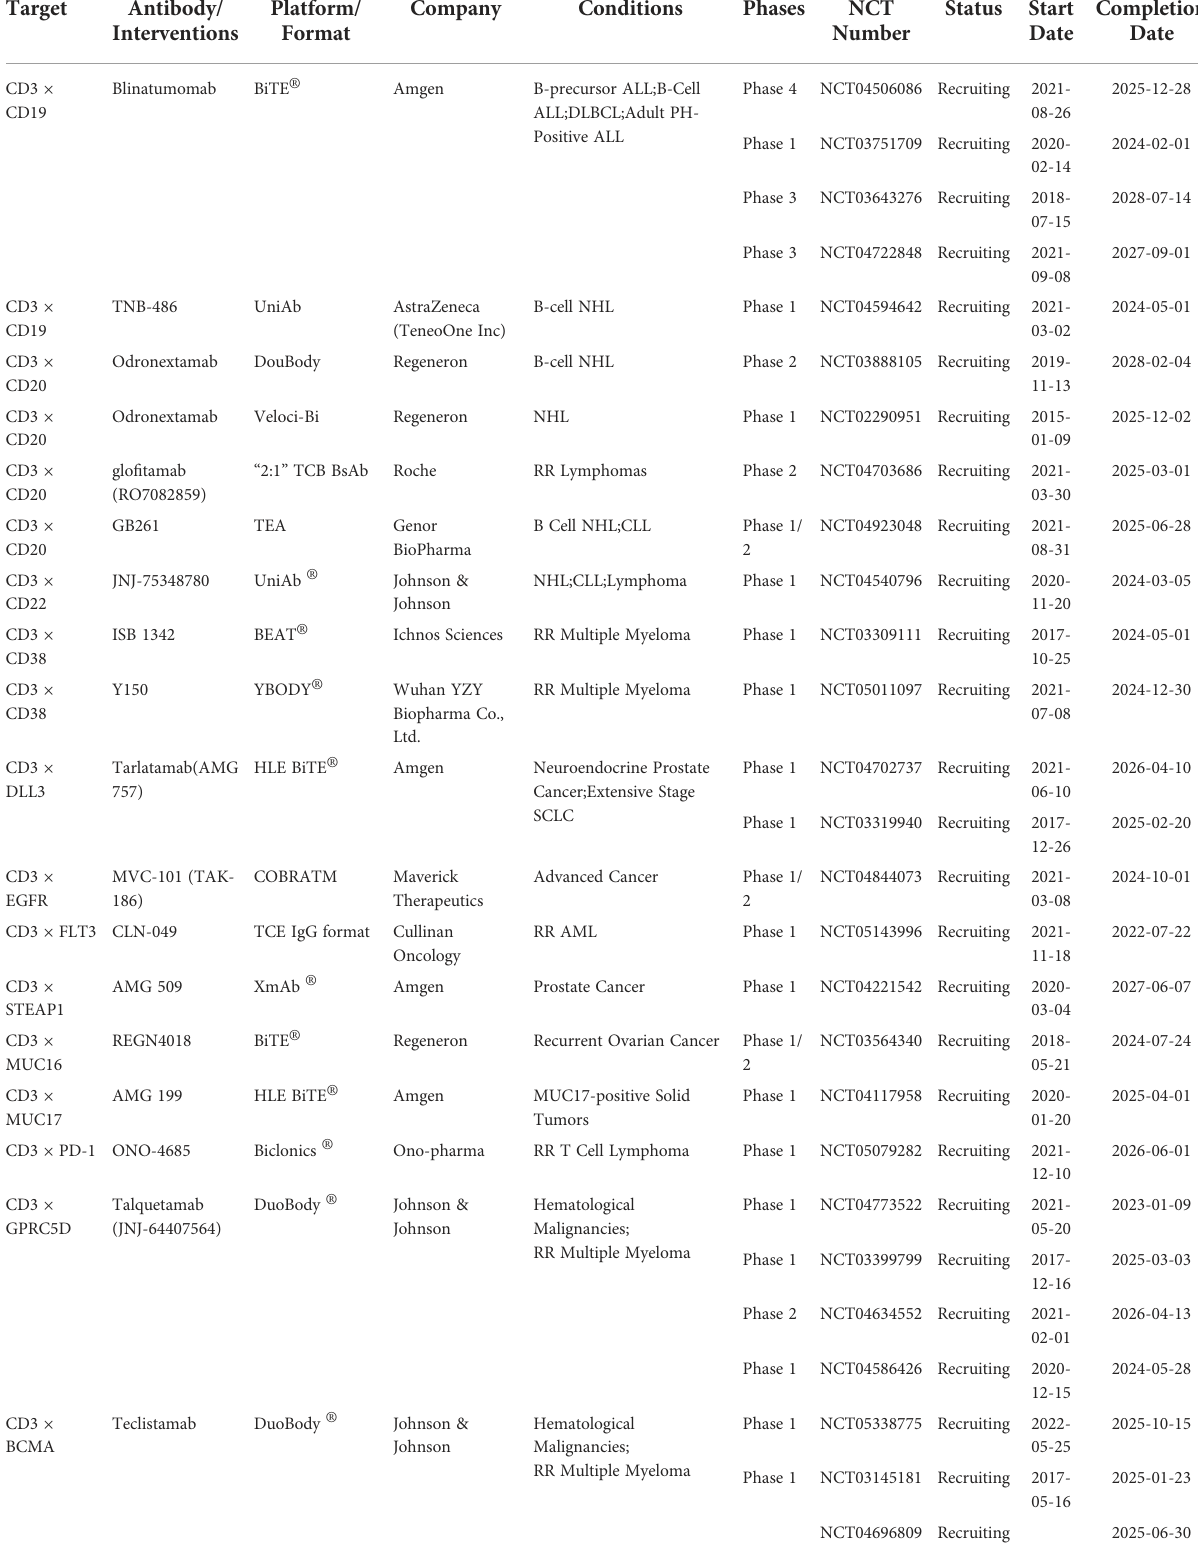
TABLE 2 Bispeci fi c Antibody Clinical Trials